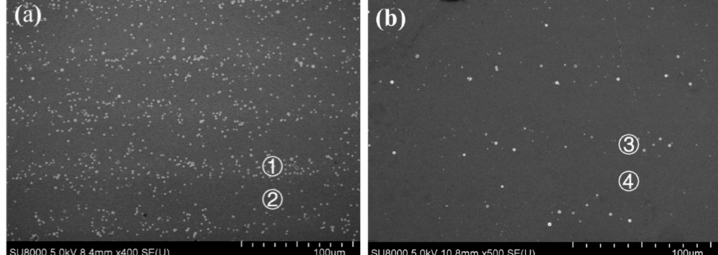
Figure 5. ( a ) FE-SEM image of the first ELO layer after plasma etching for 15 min. ( b ) FE-SEM image of the second ELO layer after plasma etching for 15 min.